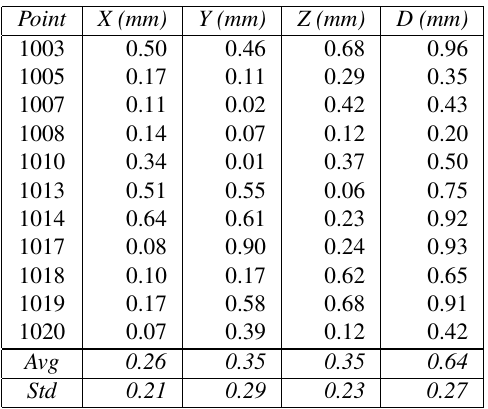
Table 2. Residual of CPs in detail of Case 1-Method 2